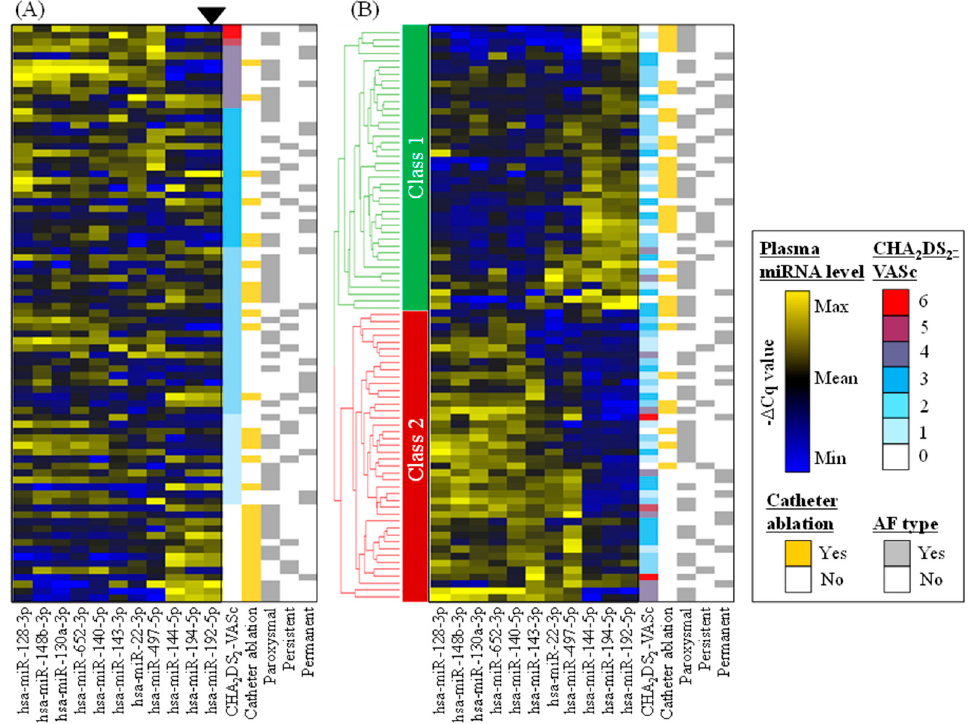
Figure 2. Plasma levels of miRNAs which were correlated with both CHA 2 DS 2 -VASc score and CA. Plasma levels (i.e., − ∆ C q values) of 11 miRNAs, whose plasma levels showed correlations with both CHA 2 DS 2 -VASc score and CA operation, are presented as heat maps. ( A ) The data was sorted with CHA 2 DS 2 -VASc score; ( B ) Plasma levels of the 11 miRNAs were subjected to hierarchical clustering. Based on the circulating miRNA profile, Class 1 and Class 2 patients are supposed to be associated with low and high stroke risks, respectively. The number of AF patients with paroxysmal-, persistent- and permanent-type were 48, 13 and 22, respectively, and 32 patients received CA operation during the study period. Note that plasma levels of the miRNA are high when their − ∆ C q is high. Yellow, black and blue colors represent high, middle and low expression levels of miRNAs, respectively. Red, blue and white colors represent high, middle and low CHA 2 DS 2 -VASc scores, respectively.